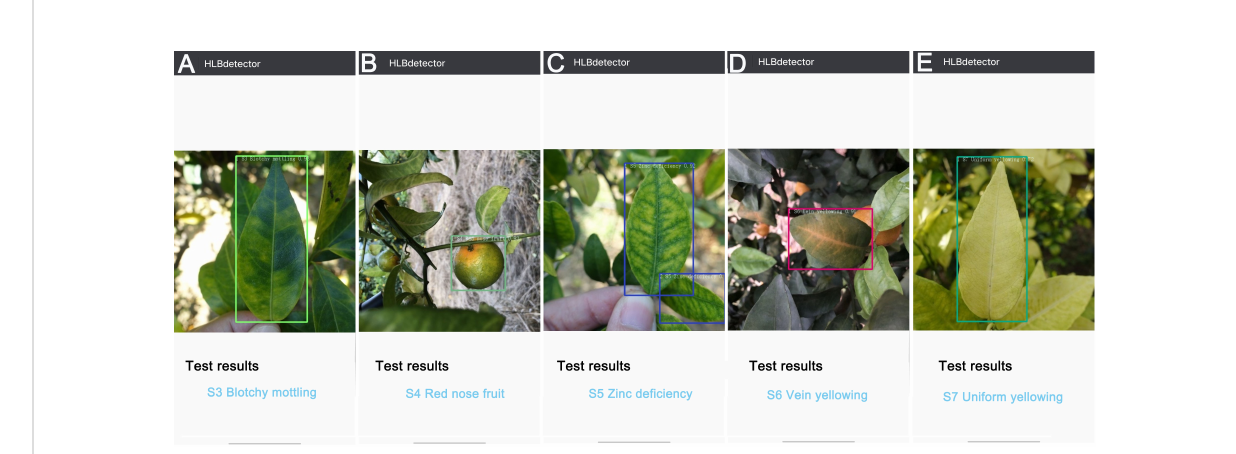
FIGURE 8 Examples of detection results for fi ve citrus HLB symptoms using ‘ HLBdetector ’ . (A) , blotchy mottling (S3); (B) , “ red-nose ” fruits (S4); (C) , zinc- de fi ciency (S5); (D) , vein yellowing (S6); (E) , uniform yellowing (S7). Note: The colour of hollow squares outside leaves and fruits is randomly selected by the ‘ HLBdetector ’ software.